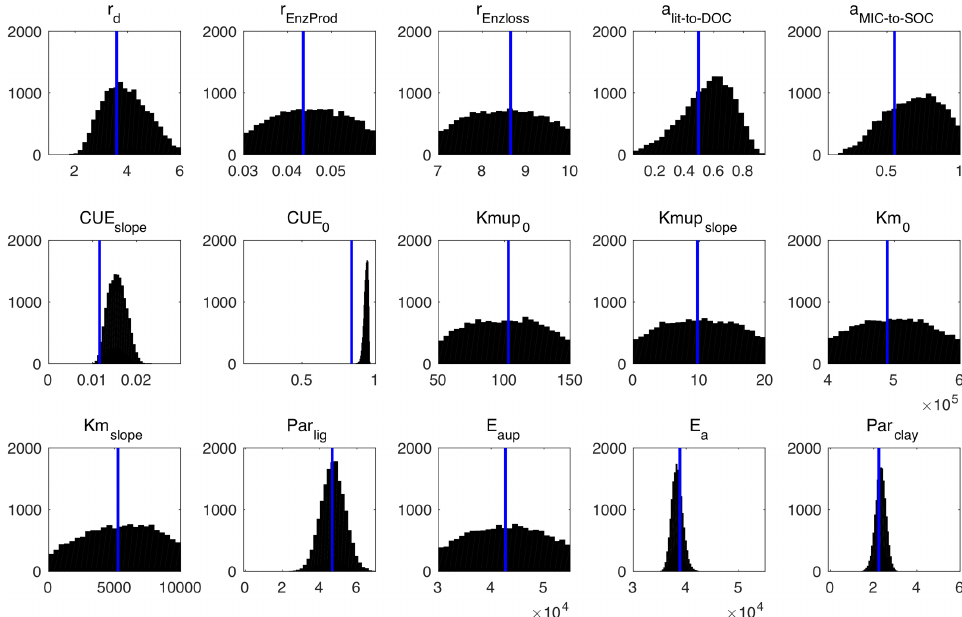
Figure 10. Posterior probability density functions of the four-pool microbial model parameters (generated by Bayesian MCMC). The blue vertical lines are the final calibrated parameter values from our surrogate-based